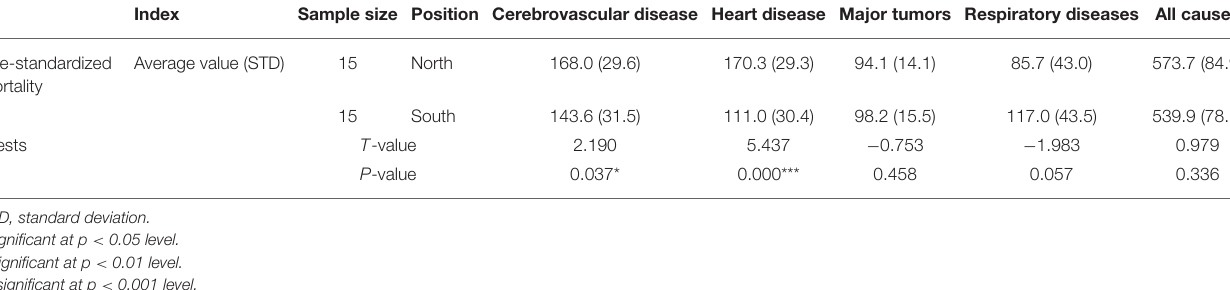
TABLE 1 | Age-standardized mortality rates (1/100,000) and t -tests of major diseases between northern and southern China. Index Sample size Position Cerebrovascular disease Heart disease Major tumors Respiratory diseases All causes